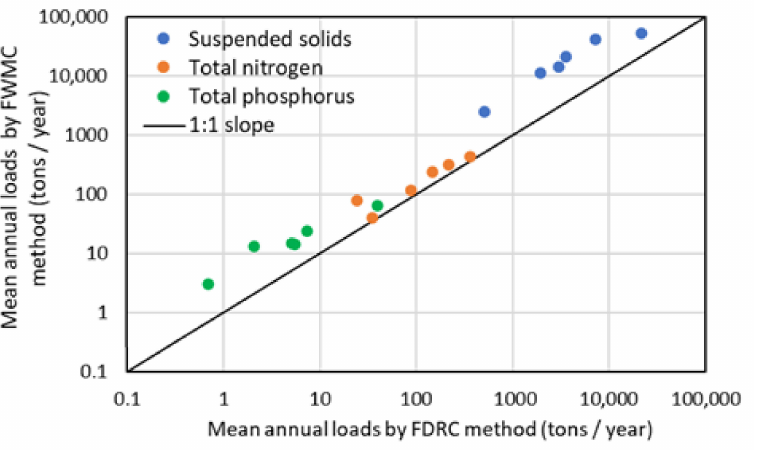
Figure 15. Comparison of the mean annual loads calculated for the six watersheds using the FDRC and FWMC methods (plotted on a log